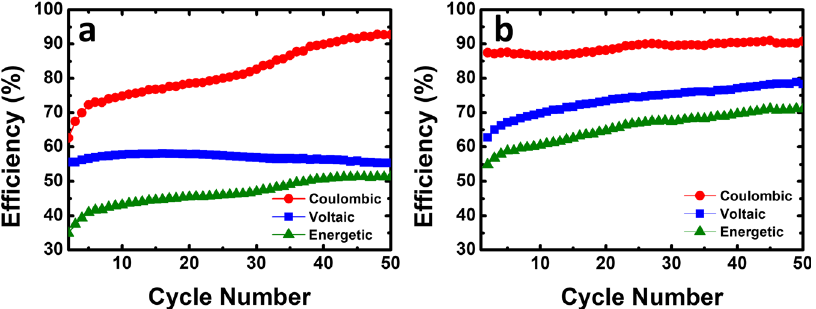
Fig. 7 System ef fi ciencies. Coulombic ef fi ciency, voltaic ef fi ciency, and energetic ef fi ciency plots of neutral pH aqueous organometallic and all-organic active materials for RFB single cells using 5.0 mM of TRYP-SO 3 H in 1.0 M KCl as supporting electrolyte. a 10.0 mM of K 4 [Fe(CN) 6 ]·3H 2 O as catholyte. b 5.0 mM of BQDS as